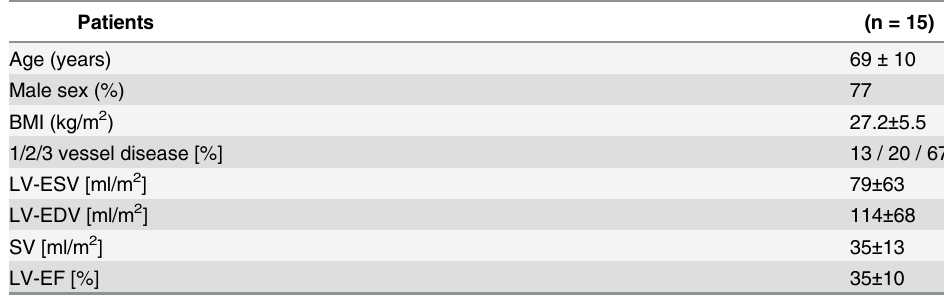
Table 1. Subject Characteristics.